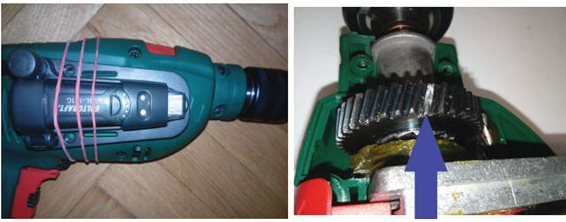
Figure 1: Sample of motor in industries